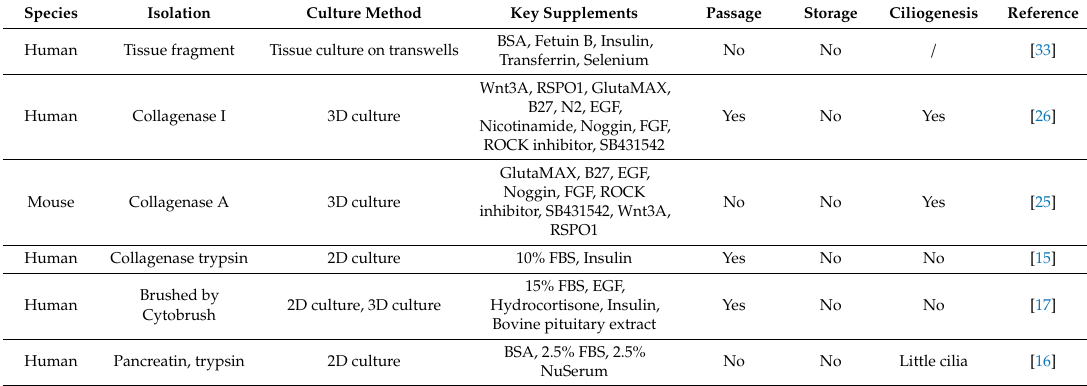
Figure S1: Identification of primary FTECs. Figure S2: Purification of FTECs co-cultured with MEFs. Video S1: Ciliary motility of FTECs cultured in